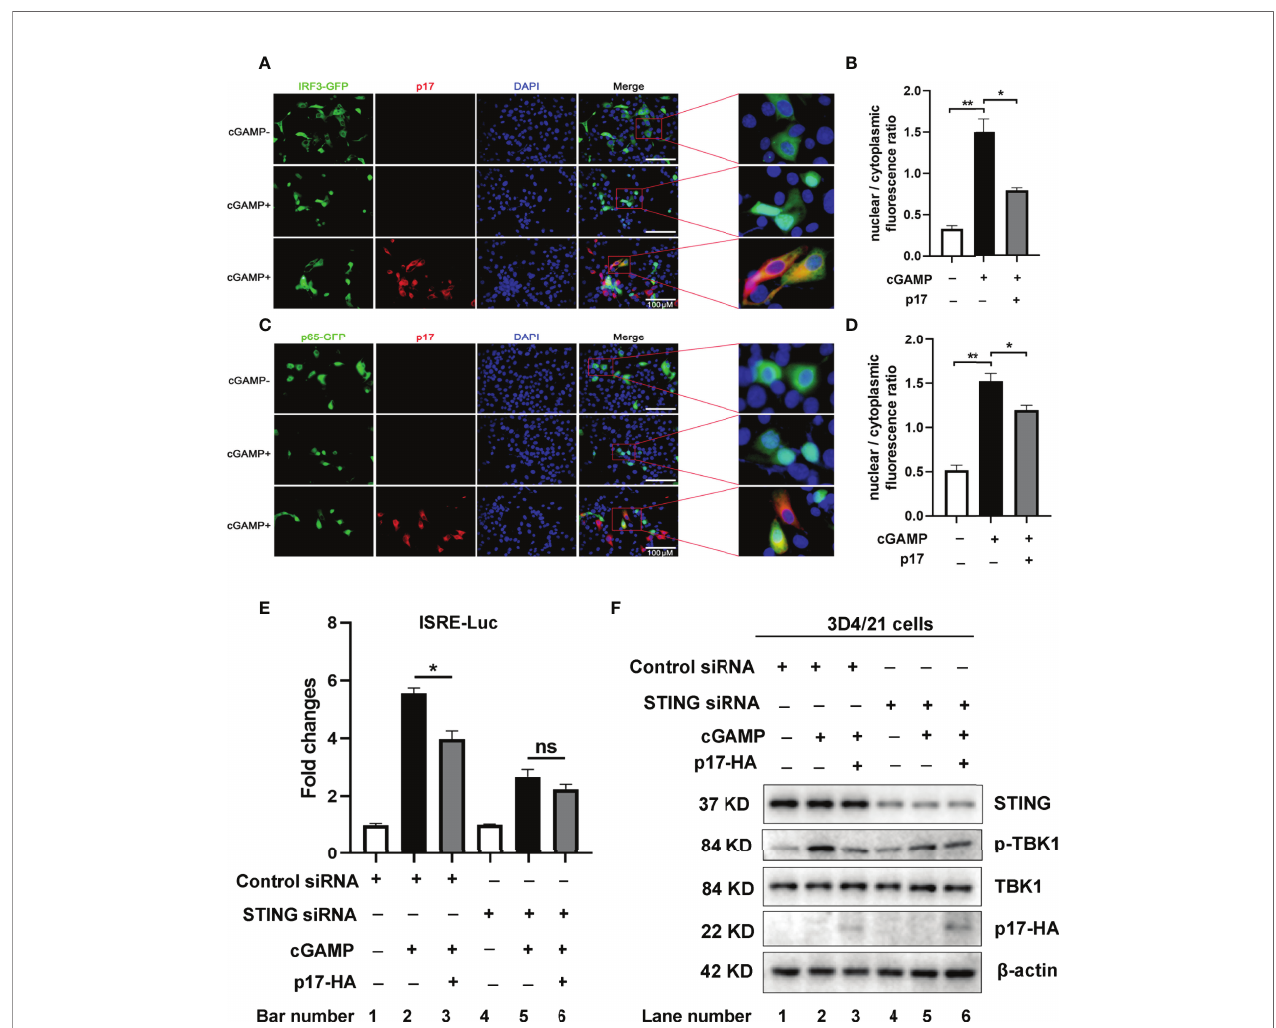
FIGURE 2 | (A-D) The effects of ASFV p17 on nuclear translocations of IRF3 and NF- k B p65. The 3D4/21 cells grown on the coverslips in 24-well plates (1×10 5 cells/ well) were transfected with IRF3-GFP (0.5 m g) and pCAGGS-p17-2HA (0.5 m g) or control vector (0.5 m g) (A, B) , p65-GFP (0.5 m g) and pCAGGS-p17-2HA (0.5 m g) or control vector (0.5 m g) (C, D) using Lipofectamine 2000. At 18 h post translation, the cells were stimulated with transfection of 2 ’ 3 ’ -cGAMP (1 m g/ml) for another 6 (h) The cells on coverslips were sequentially probed with rabbit anti-HA mAb, goat anti-rabbit IgG H&L Alexa Fluor 594, counter-stained with nucleus marker DAPI. (A) The effects of ASFV p17 on nuclear translocations of IRF3 was observed by fl uorescence microscope with the enlarged images shown on the right. (B) Statistical analysis of the ratios of IRF3-GFP in nuclear fractions vs cytoplasmic fractions. (C) The effects of ASFV p17 on nuclear translocations of p65 was observed by fl uorescence microscope with the enlarged images shown on the right. (D) Statistical analysis of the ratios of p65-GFP in nuclear fractions vs cytoplasmic fractions. (E, F) 3D4/21 cells in 24-well plates were transfected with the STING siRNA or Control siRNA (50 nM) by lipofectamine 2000 for 24 h, followed by co-transfected p17, ISRE-Fluc and Rluc for 12 h, and then stimulated by cGAMP for another 12 h. (E) Effects of the activation of ISRE promoter were detected by luciferase measurement. (F) Effects of the phosphorylation of TBK1 (p-TBK1) were detected by Western blot. Fold change values represent the mean±S.D. * P <0.05, ** P <0.01, ns not signi fi